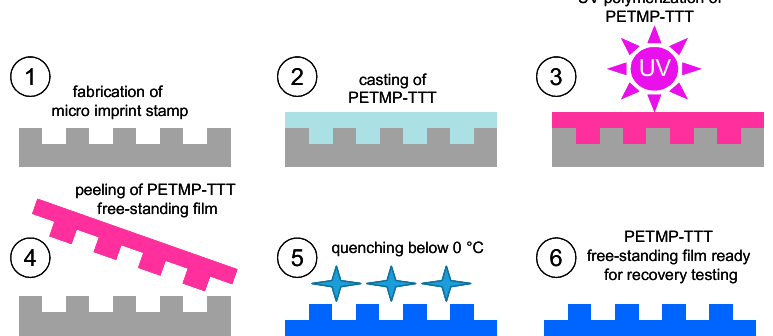
Figure 2. Schematic representation of the microstructured PETMP-TTT film fabrication process from steps (1) to (6).